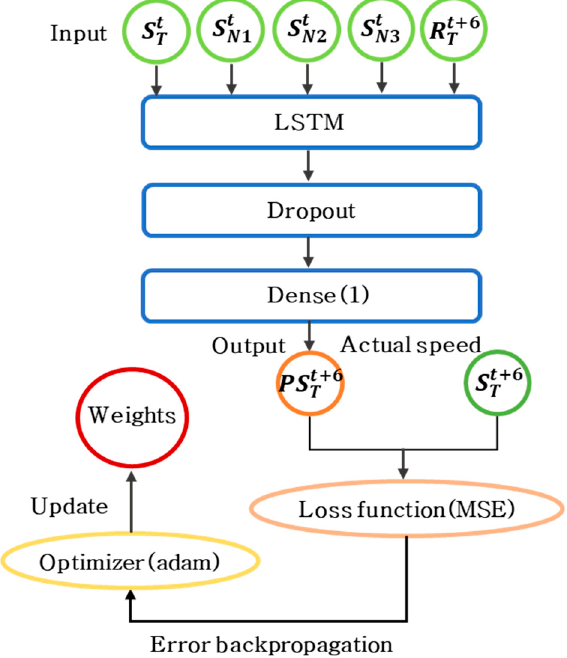
Figure 5. Training process of LSTM